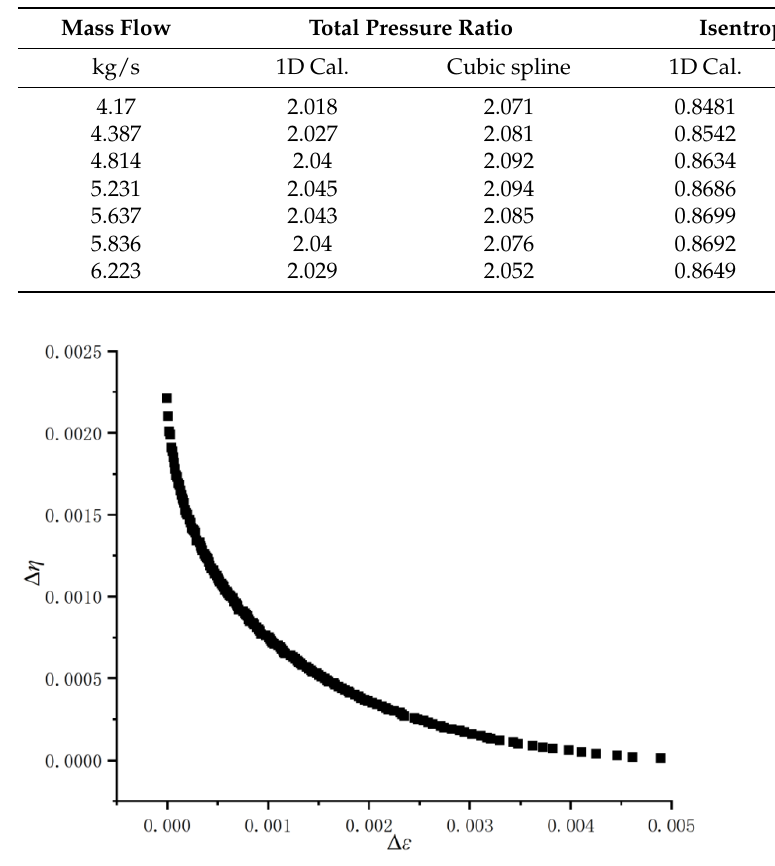
Figure 10. Pareto front for the Eckardt-O impeller.